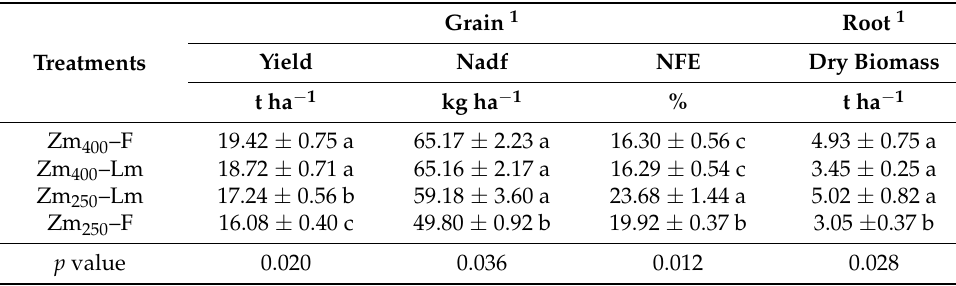
Table 5. Comparison of means for the interactions in the yield variables, nitrogen uptake